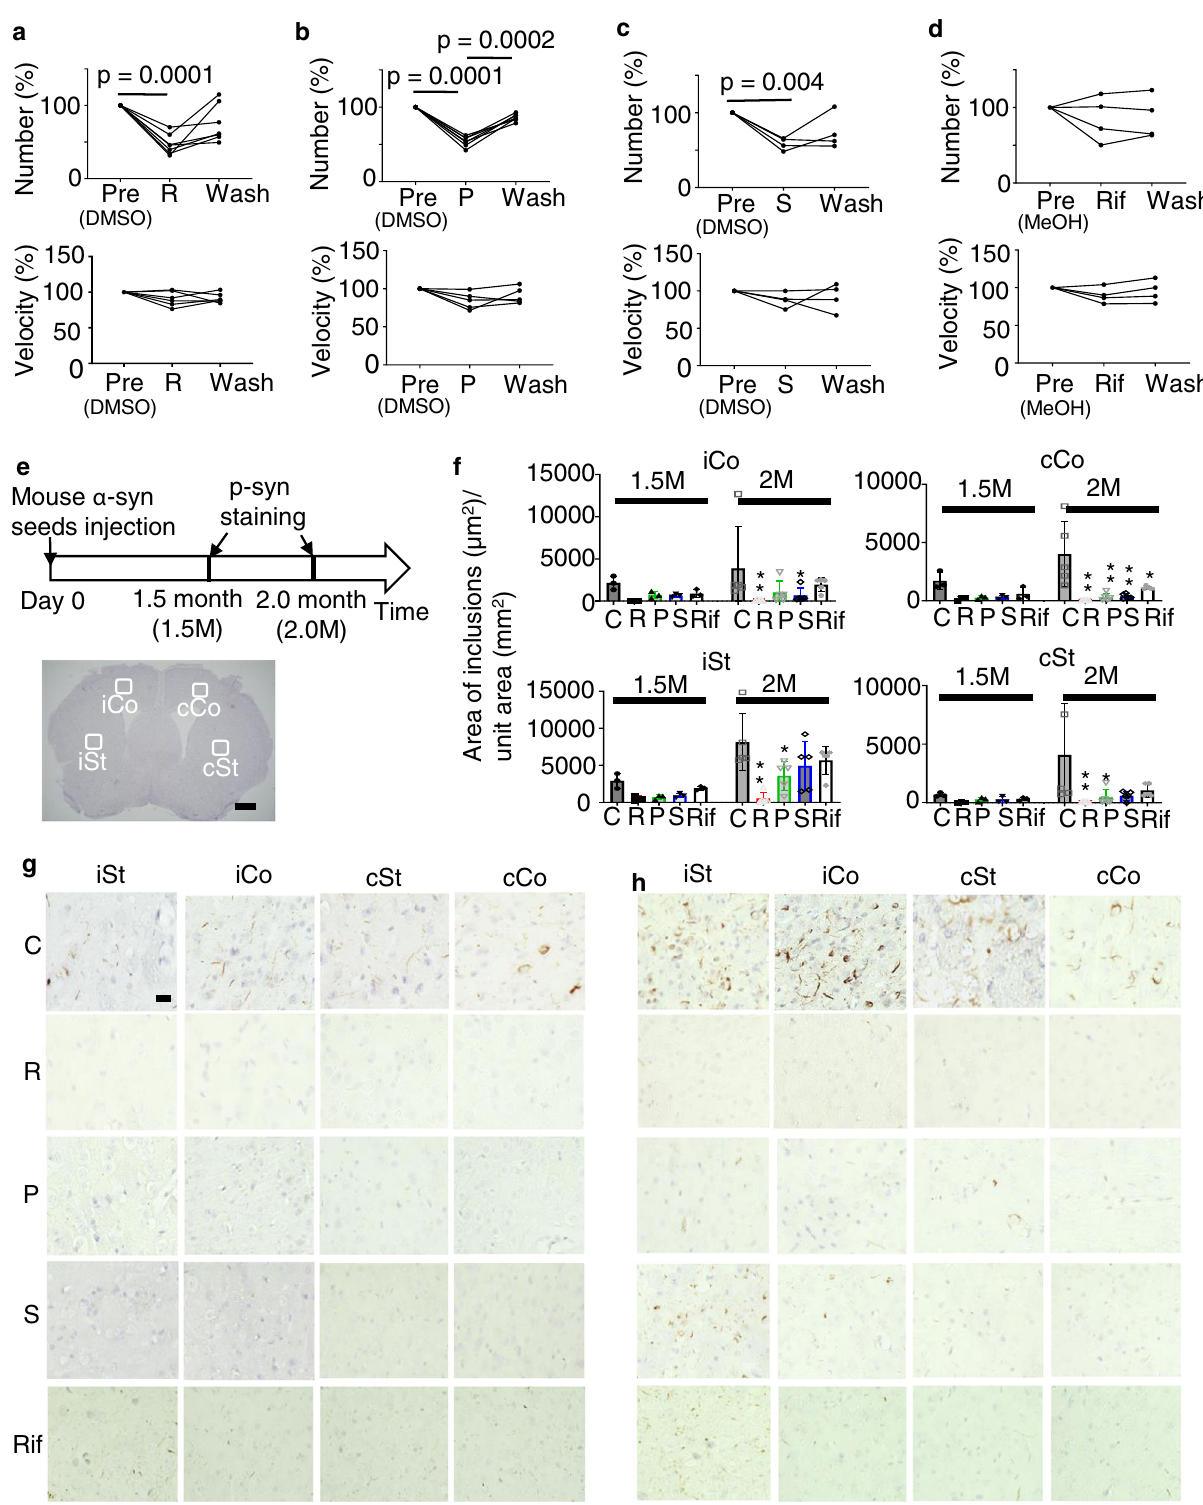
Fig. 5 Effect of clinically available drugs on α -syn seed dynamics in the acute slice and transmission experiment. a – h The effects on α -syn seed numbers (top) and mean velocity(bottom) in acute slice assay by riluzole(R) ( a ), perampanel(P) ( b ), sertraline(S) ( c ), and rifampicine(Rif) ( d ). e Experimental procedure for chronic drug effects on phosphorylated α -syn (p-syn) pathology after mouse α -syn seeds injection (in vivo transmission experiment). ROI iSt ipsilateral striatum, iCo ipsilateral cortex, cCo contralateral cortex, cSt contralateral striatum. Bar: 500 μ m. f Quantitative analyses for p-syn expression in mice ( n = 3 mice, respectively). * p < 0.05, ** p < 0.01 compared to C. C control (injection of PBS), Pathology was examined at 1.5 M g and 2.0 M h after mouse α -syn seed injection. Bar: 10 μ